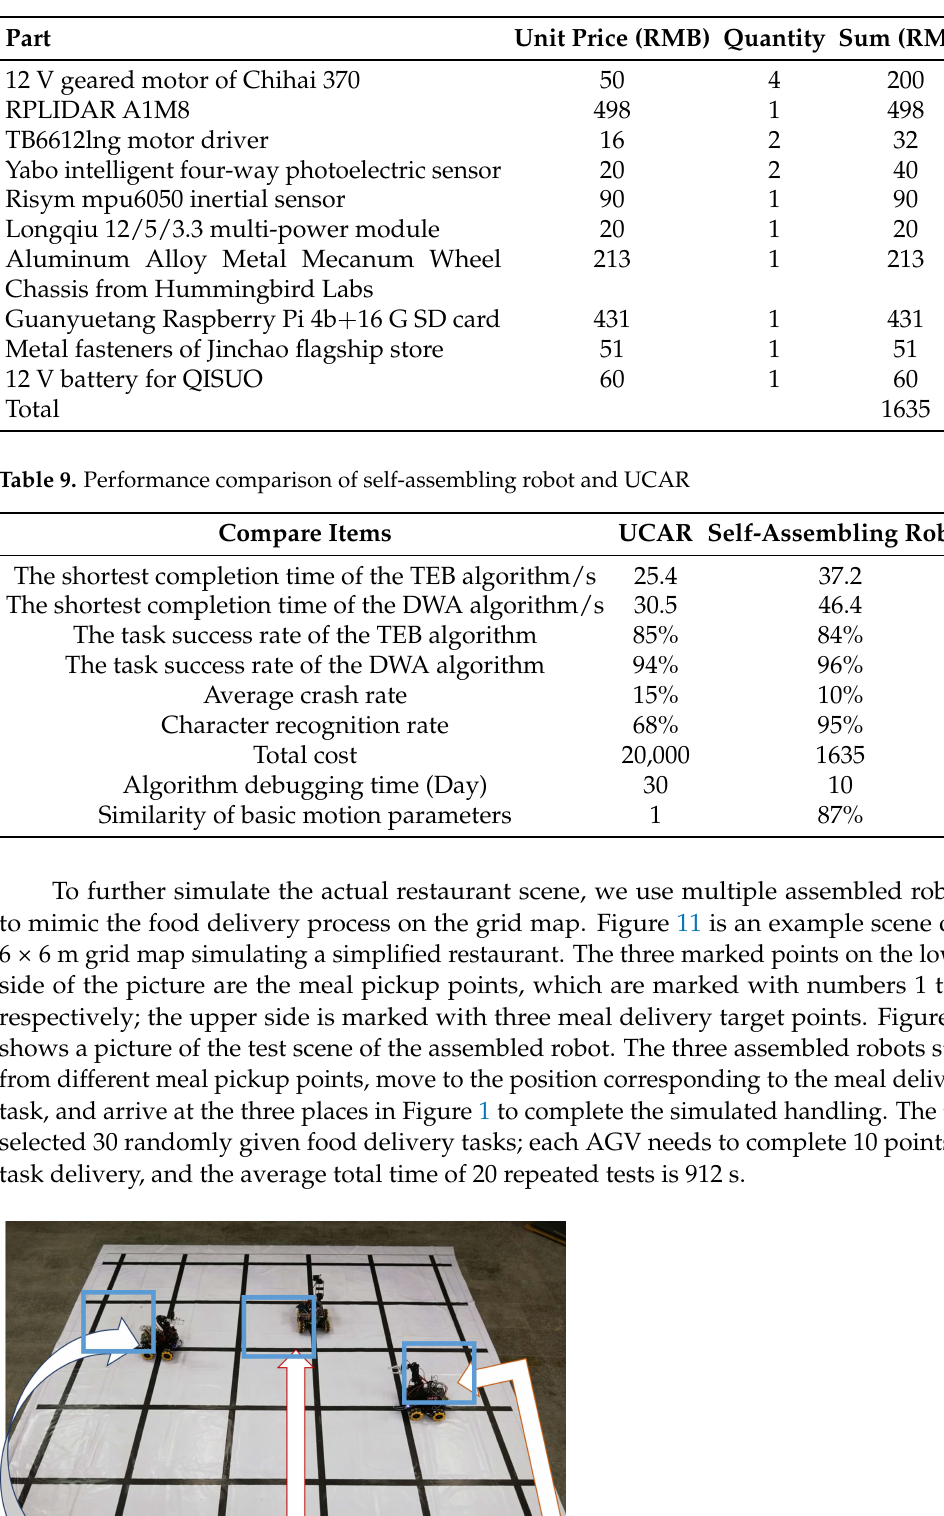
Table 8. The prices of the main parts of the assembled robot.